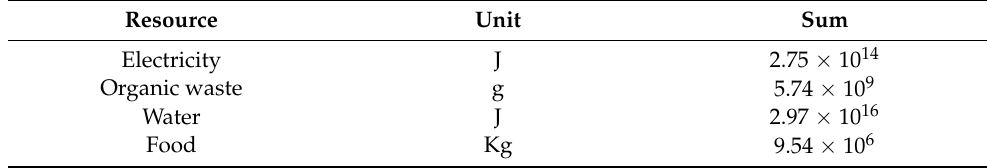
Table 1. Waste discharge and energy consumption in Downtown Providence. Resource